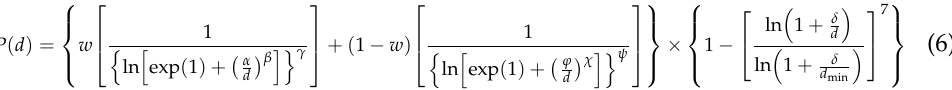
Figure 1. Illustration and comparison of the three criteria. ( a ) Three most commonly used semi- empirical criteria. ( b ) Slope criteria of soil PSD curves. Based on the research ideas of Chapuis, many scholars try to combine the Kezdi, Sherard, and Kenney and Lau criteria to the assessment of soil instability. Li and Fannin [17] obtained a plot of the Kezdi and the Kenney and Lau boundaries in the F : H space. In addition, Moraci et al. [10,18] developed a butterfly wing chart that was successfully used to distinguish stable and unstable soil particle distributions despite two issues that exist for the coordinate variables, which may not be the most reasonable [2,19]. However, there are certain issues that have to be sorted out in order to determine the soil PSD curves ’ secant slopes: (1) PSD information on many soils is derived, (2) some specific PSD data are difficult to obtain using sieve analysis, and (3) the secant slopes of soil PSD curves can only be computed manually [2,20]. In this paper, a new method to calculate the soil PSD curves ’ secant slopes automat- ically is proposed, and a synthetic diagram is presented for the potential examination of